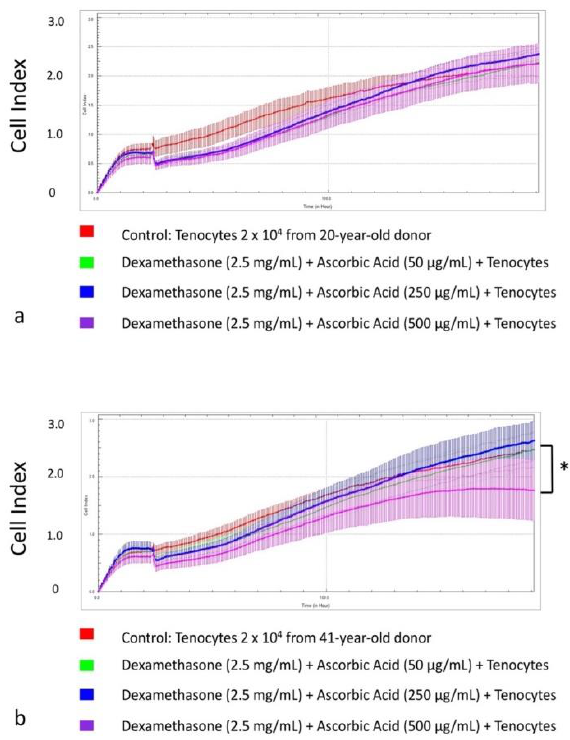
Figure 6. Real-time changes of cell index when tenocytes were exposed to 2.5 mg/mL of dexamethasone and different concentrations of ascorbic acid. ( a ) Cell index when tenocytes were exposed to 50, 250, and 500 μg/mL ascorbic acid in the 20-year-old patient. ( b ) Cell index when tenocytes were exposed to 50, 250, and 500 μg/mL ascorbic acid in the 41-year-old patient. * p < 0.05.